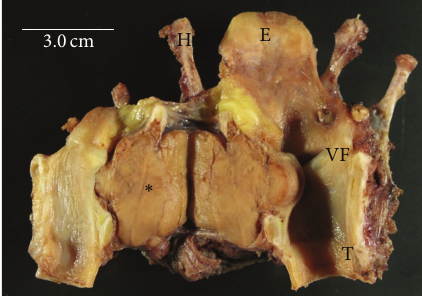
Figure 3: From behind, the laryngectomy specimen reveals a giant cell tumor under the intact mucosa ( ∗ ). E: epiglottis, H: hyoid bone, T: trachea, VF: vocal fold, and scale bar = 3.0